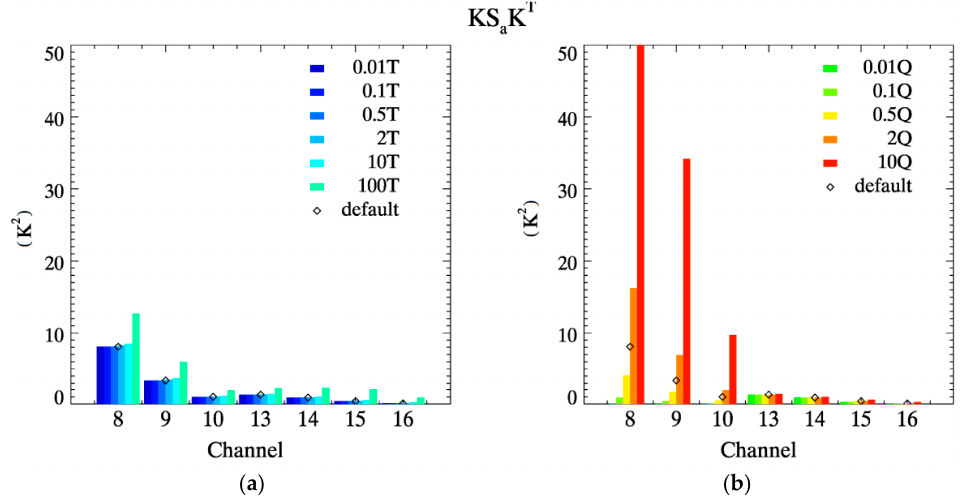
Figure 4 Figure 4. Sensitivity of KS a K T to the change in ( a ) temperature and ( b ) moisture error covariance